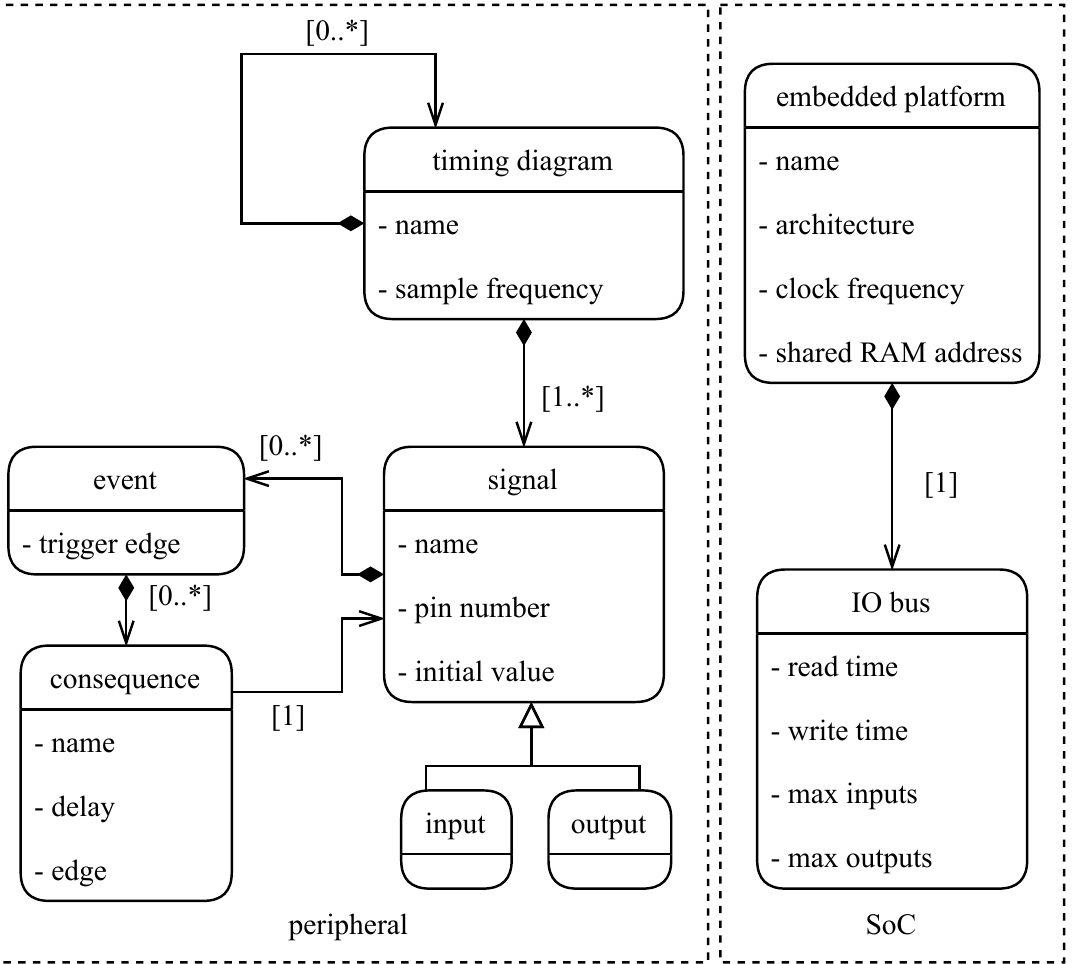
Figure 4. Simplified class diagram of the combined model. In the model, two main components are defined: a timing diagram and an embedded platform. The timing diagram is defined as a sequential series of events, with each event representing an output or input change at a specified time. This series of events is then matched to the sample frequency in the next stage. The embedded platform definition contains the read and write times, as well as the clock frequency; these are necessary to form the timing plan in the next stage. The architecture and name parameter are necessary for the compiler selection. The shared RAM address is used for data transfer between the main and coprocessor. The complete version of the presented class diagram can be found in the publicly available repository [18] , as well as some elaborated